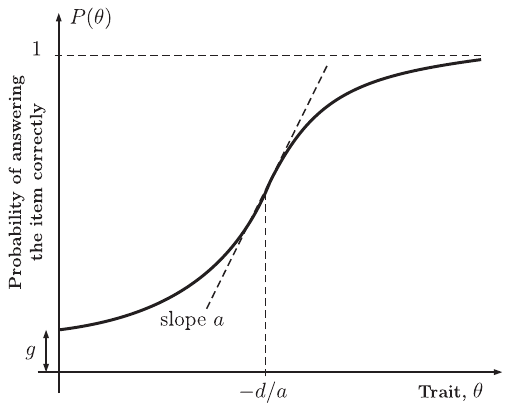
FIG. 1. The standard item response curve of a three-parameter model depicted together with the graphical interpretation of each corresponding parameter, a , d , and g